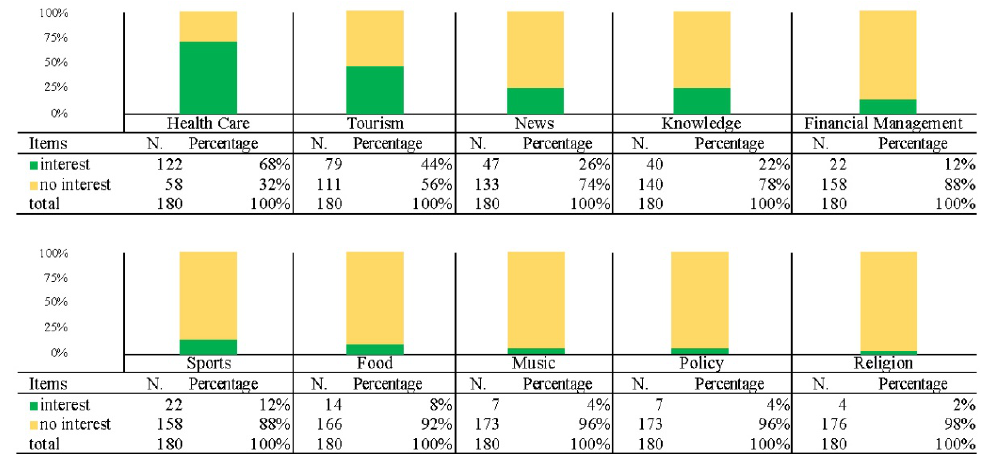
Figure 9. Descriptive statistical results of participants’ preferred self-media subjects.